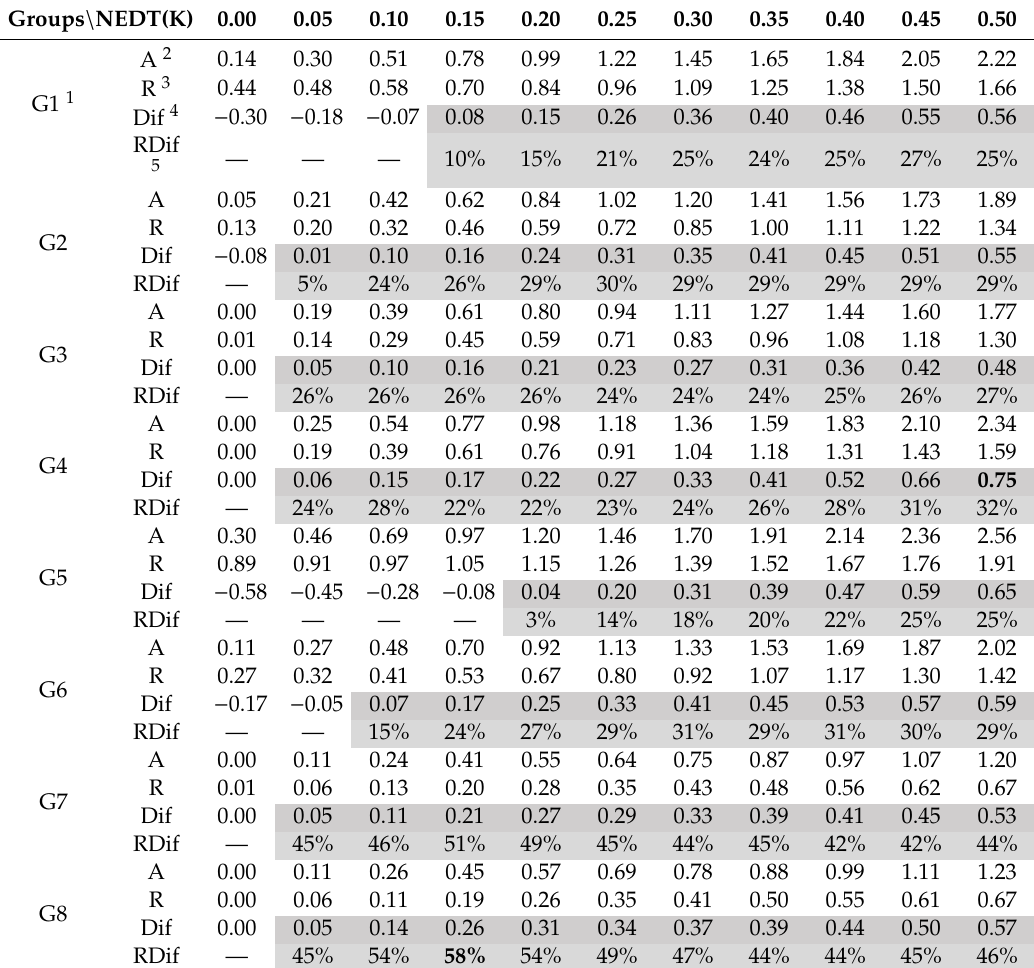
Table 3. The retrieved LST error list of the RDSS and ARTEMISS and their di ff erences. Groups \ NEDT(K)